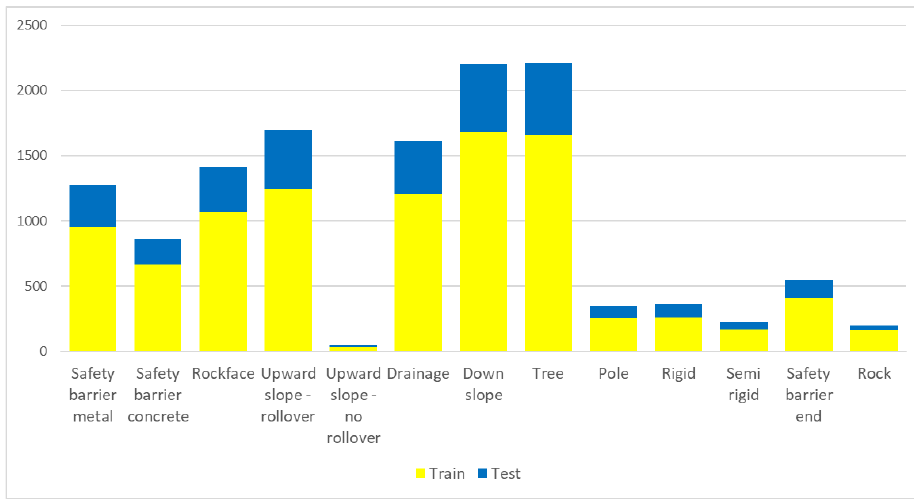
Figure 9. Distribution of labelled RSS – O classes.